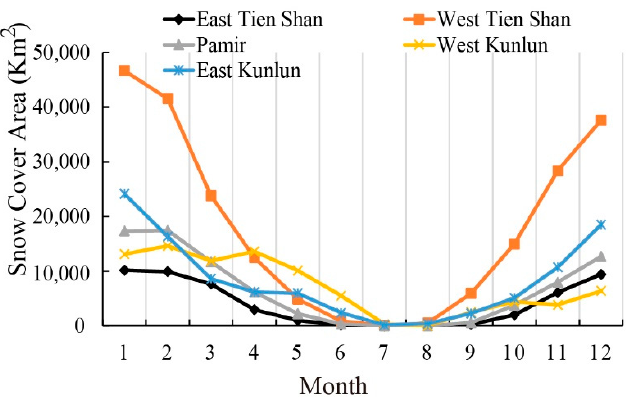
Figure 9. Mean monthly snow cover area in the five subregions of the Tarim Basin in the period of 2000–2020.